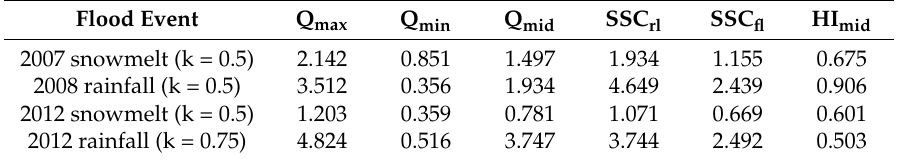
Table 4. The hysteresis index (HI mid ) of selected floods recorded in the Breelva hydrometric station. Flood Event Q max Q min Q mid SSC rl SSC fl HI mid 2007 snowmelt (k = 0.5) 2.142 0.851 1.497 1.934 1.155 0.675 2008 rainfall (k = 0.5) 3.512 0.356 1.934 4.649 2.439 0.906 2012 snowmelt (k = 0.5)